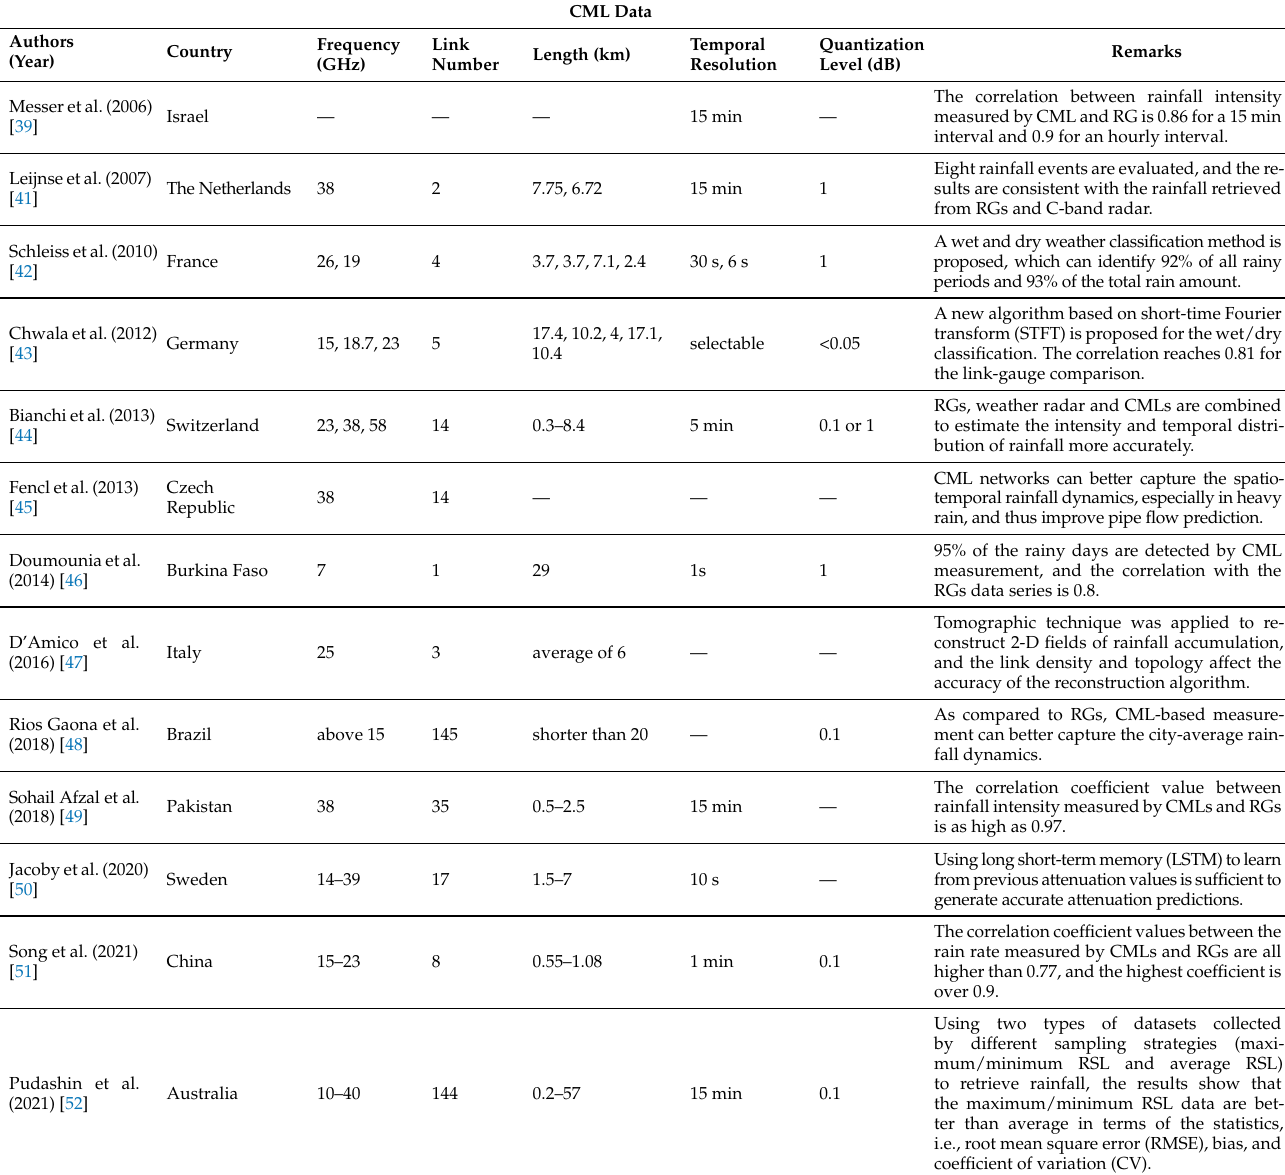
Table 2. Countries that have used CML to measure rainfall.